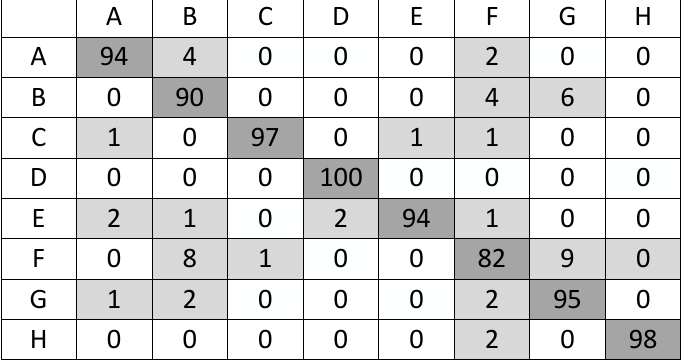
Figure 11. The effects of the ASVR denoising method on the PSR of the proposed approach. 5.3. Effects of Morphologic Filtering In this part, the new learned network is used to evaluate the validity of the morpho- logic filtering. Figure 12 shows the effects of morphologic filtering through comparative experiments. According to the picture, the recognition result of the system without mor- phologic filtering is obviously lower than that of the system with morphologic filtering in the same SNR condition. This proves that morphologic filtering can effectively improve the quality of TFDIs. This is due to the fact that the application of morphologic filtering can further remove the noise in the frequency band and smooth the edge of the image.